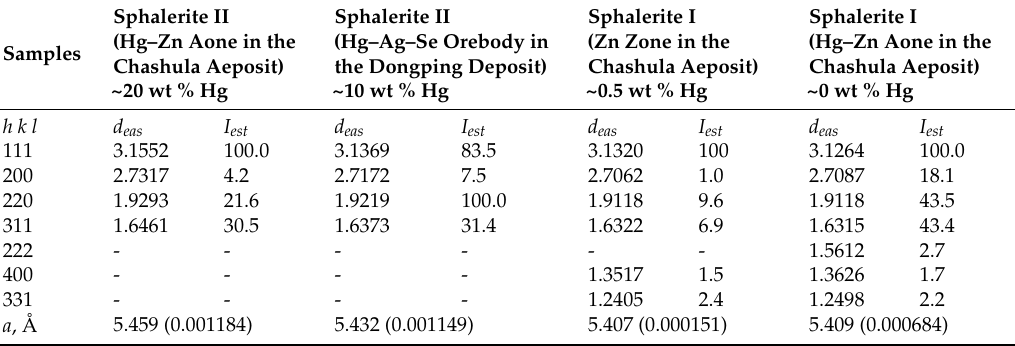
Table 4. XRD and crystallographic data for sphalerite II and I from the Chashula and Dongping deposits.